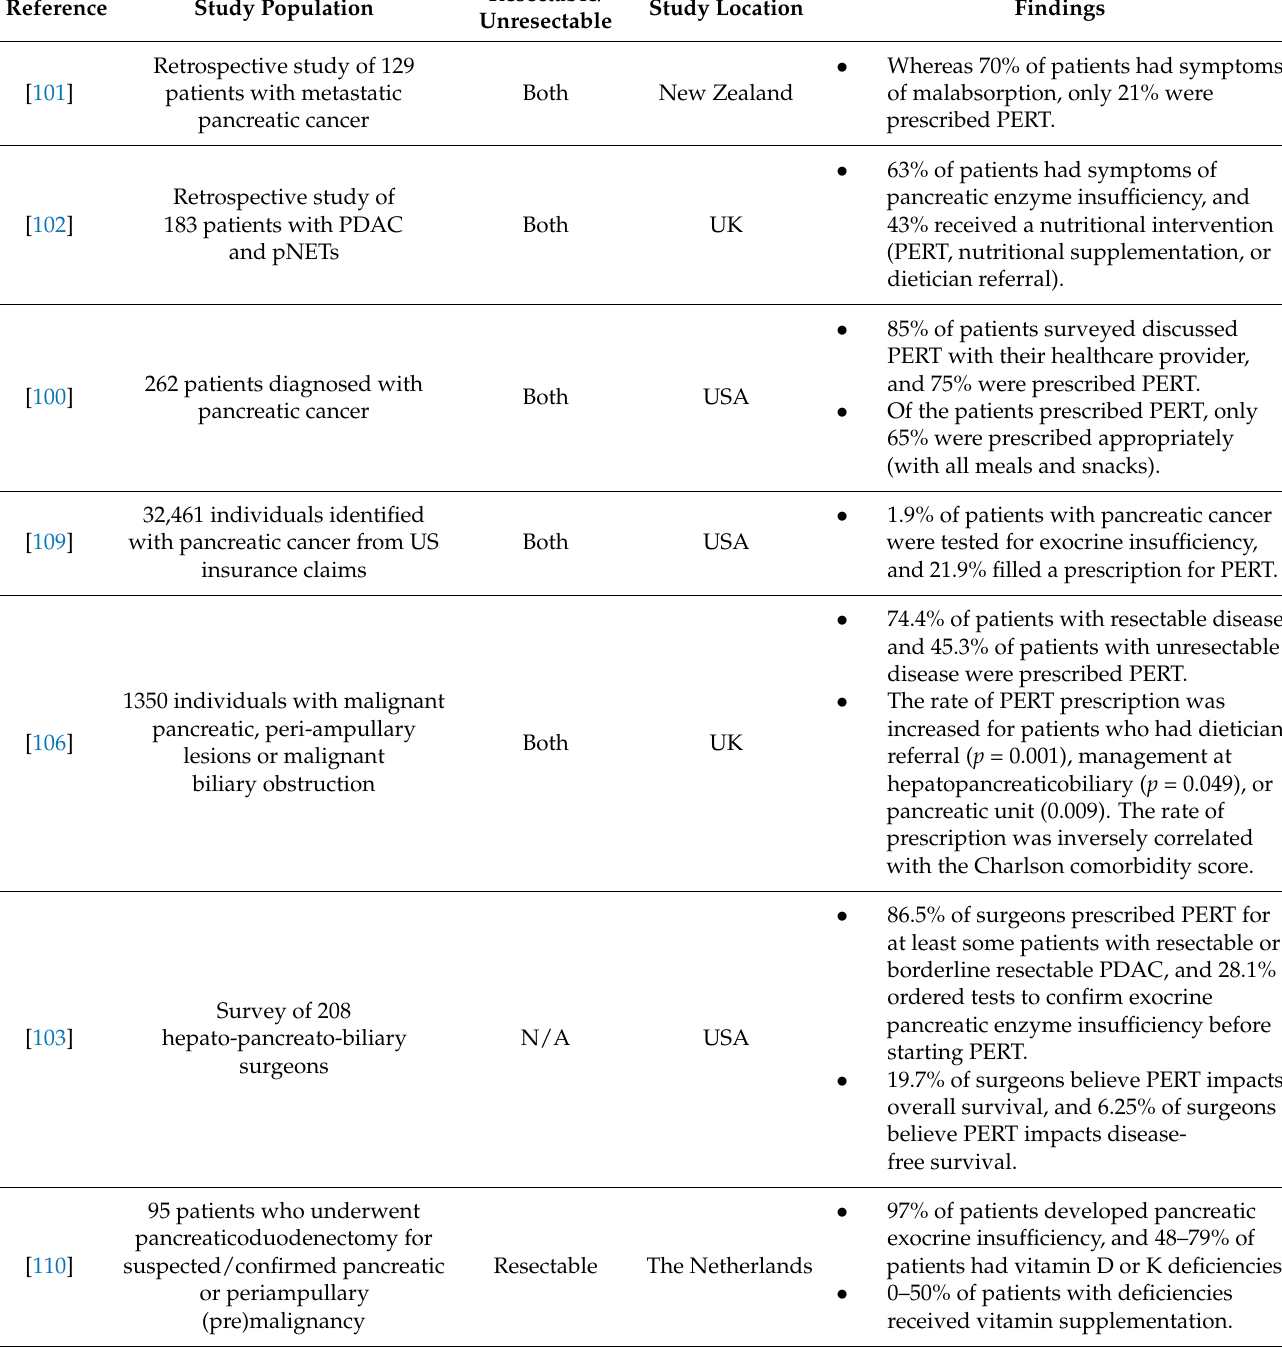
Table 1. Summary of studies examining the frequency of appropriate treatment for exocrine pancreatic insufficiency in patients with pancreatic